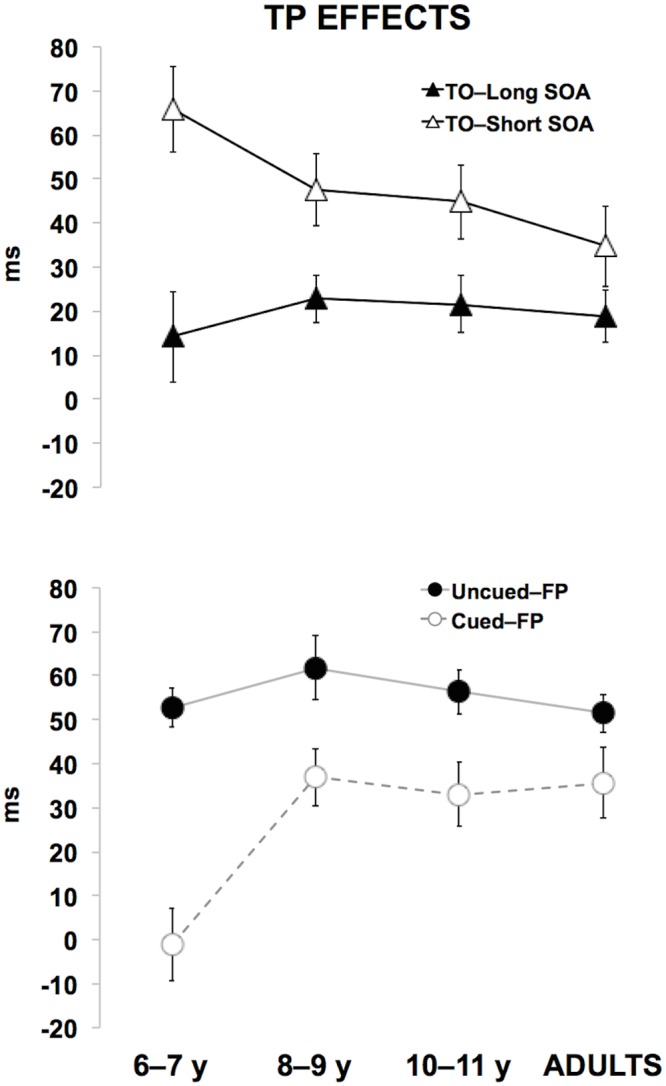
Developmental trajectories of each TP effect.The upper panel shows the developmental trajectories of each single TP effects derived by pair-wise comparisons. In particular, the upper panel shows TO–Short (T–Short minus N–Short) and TO–Long (T–Long minus N–Long) effects, both measures of E–TP. The lower panel displays the developmental trajectories of the Uncued–FP (N–Long minus N–Short) effect as a measure of I–TP and of the Cued–FP (T–Long minus T–Short) effect as a E/I–TP combined measure. Error bars indicate standard errors of the mean. Note that the analyses of variance reported in the text were performed using log-transformed data whereas the the figure shows raw data for reasons of clarity.